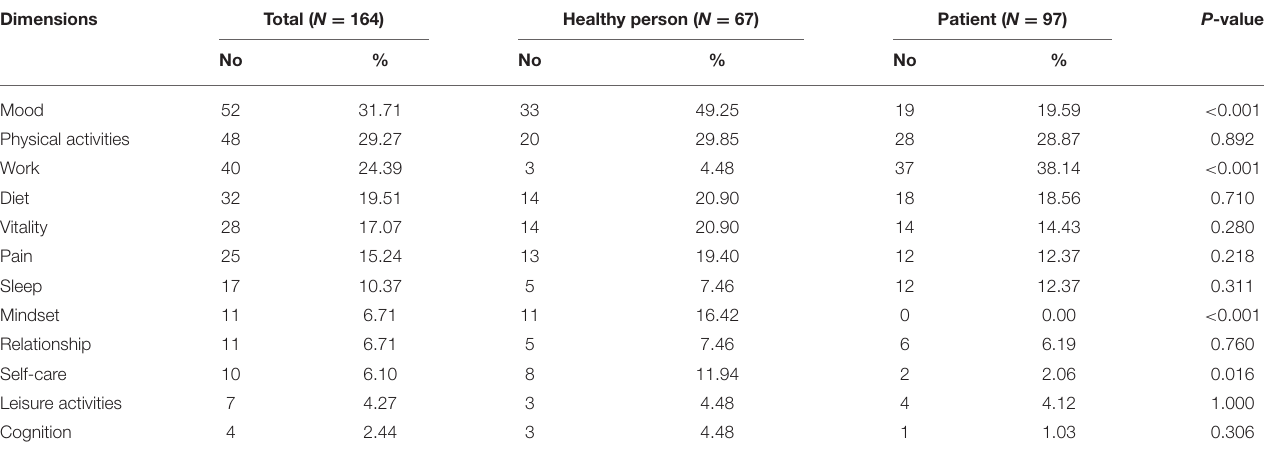
TABLE 2 | Importance of each dimension by healthy persons and patients.